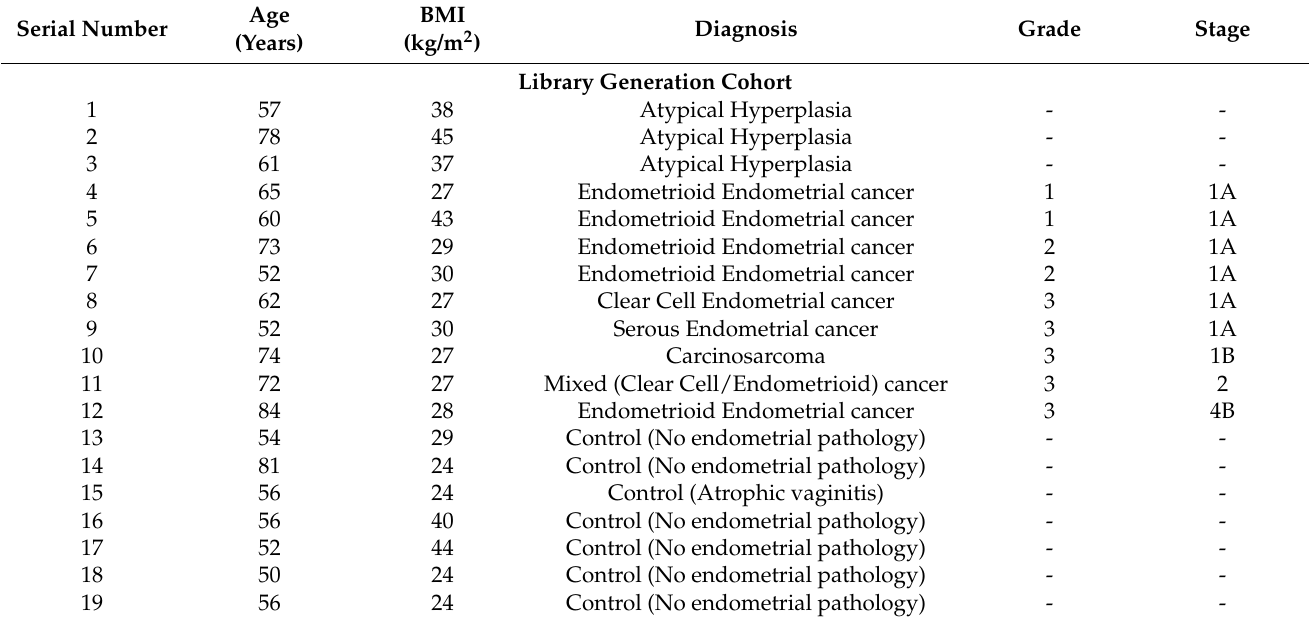
Table 2. Demographic and clinical characteristics of cases and controls whose samples were used for library